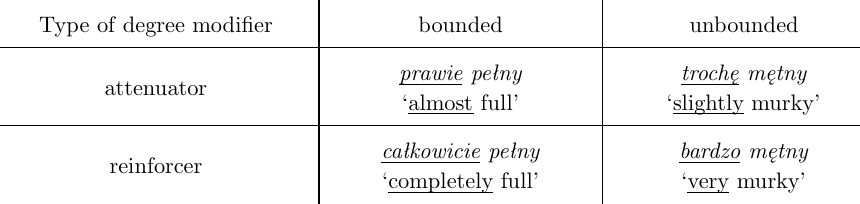
A typology of degree modifiers (based on Paradis 1997: 27) Type of degree